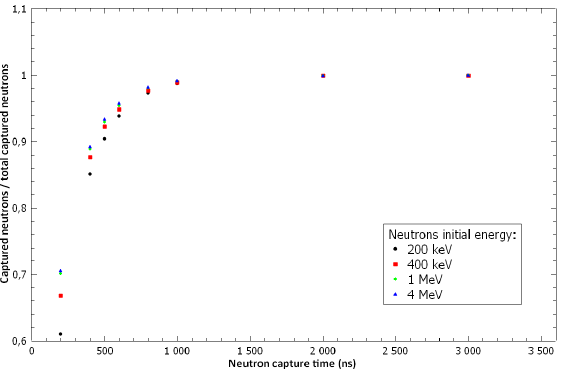
Figure 2. Ratios of neutrons captures in time (from zero to time t ) to total number of neutrons captures. Simulated neutron initial kinetic energies: 200, 400, 1000, 4000 keV. Simulated MTAS e ffi ciency for neutron capture varies from 42% at 0.2 MeV to 17% at 4